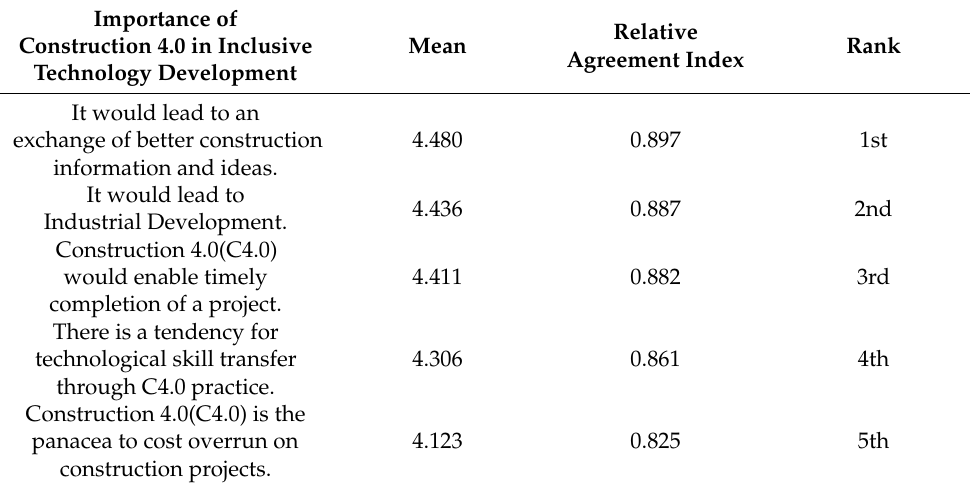
Table 15. Importance of Construction 4.0 (C4.0) in Achieving Inclusive Technological Development